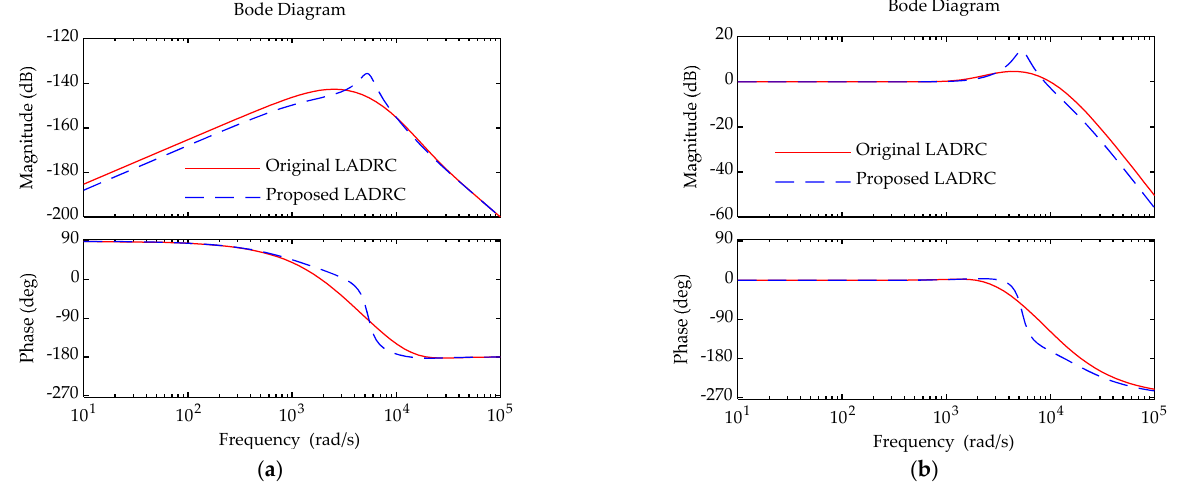
Figure 9. Bode diagrams with different schemes: ( a ) Disturbance term